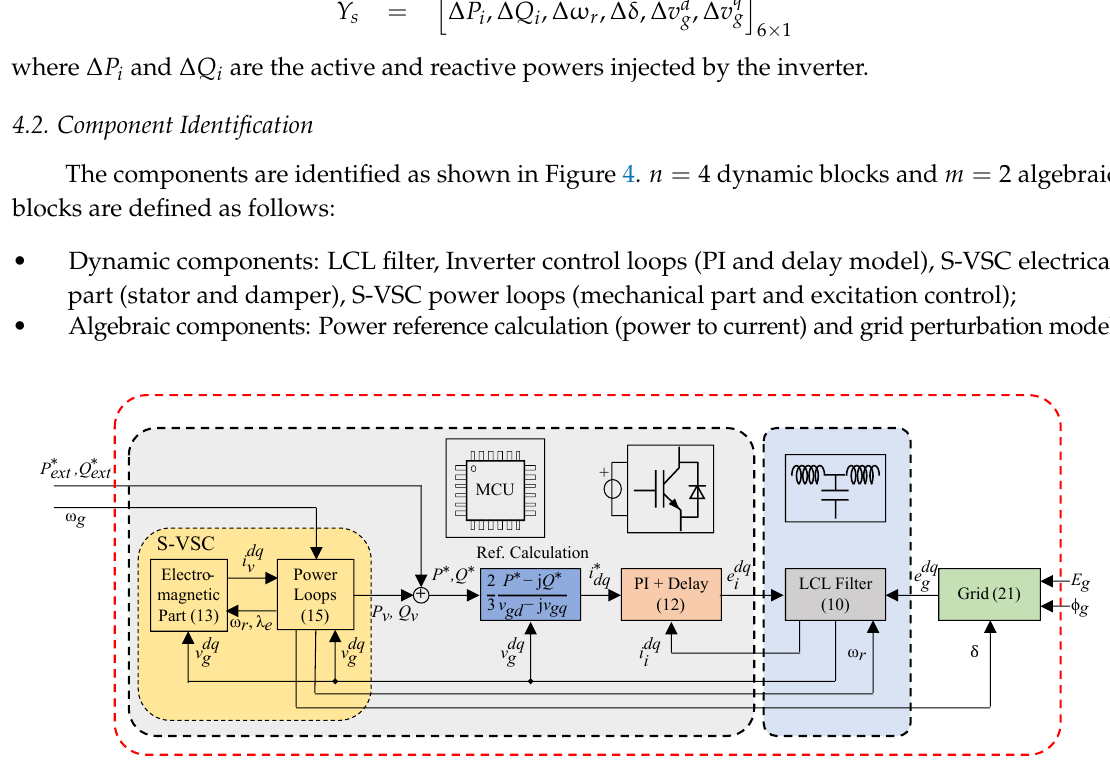
Figure 4. Block diagram of the modeled S-VSC [23] control with the physical